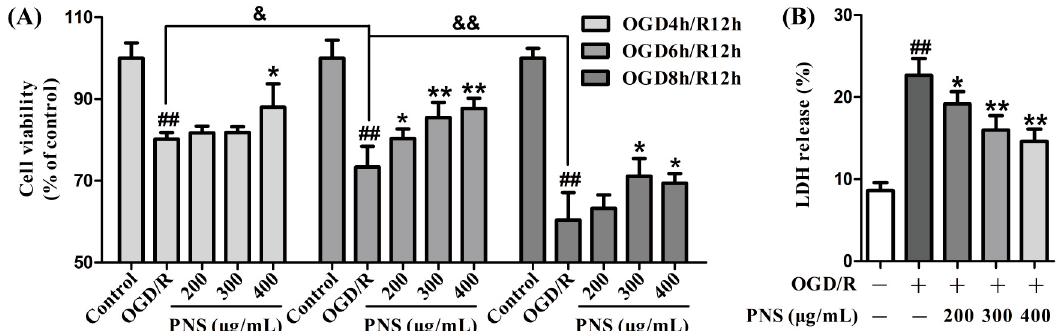
Figure 1. The protective effects of PNS against OGD/R-induced injury of bEnd.3 cells. ( A ) MTT assay to evaluate the protective effects of PNS against OGD/R-induced decrease of cell viability in different injury time. ( B ) LDH release assay to further confirm the protective role of PNS on OGD6h/R12h-induced cytotoxicity. Data are expressed as mean ± SD (N = 4). & p < 0.05, && p < 0.01, ## p < 0.01 vs. Control group, * p < 0.05 and ** p < 0.01 vs. OGD/R